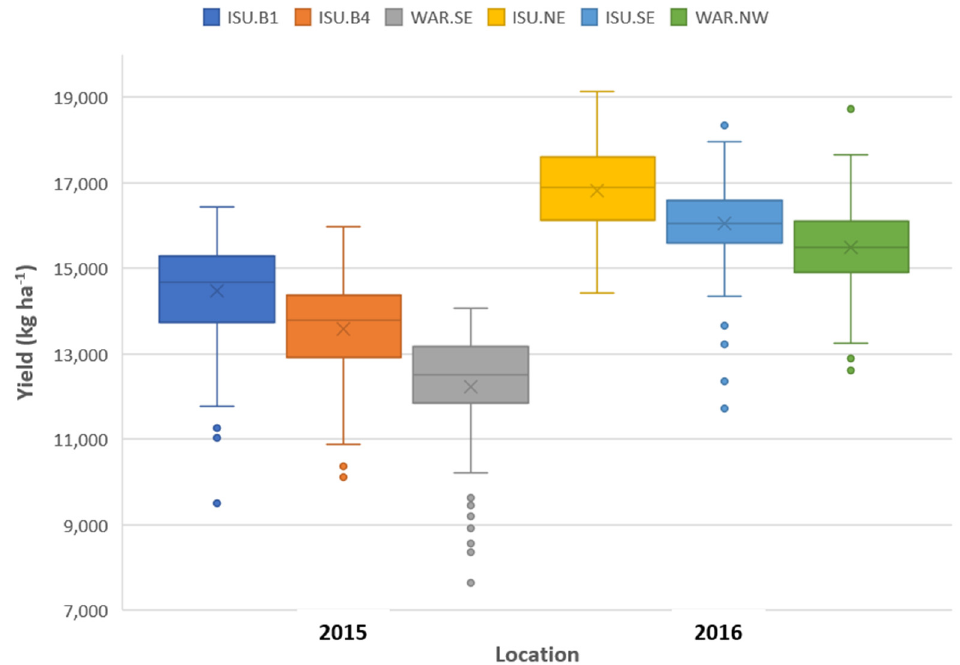
Figure 1. Summary statistics for six maize uniformity trials conducted to investigate the influence of plot size and shape on soil heterogeneity. X denotes the mean, horizontal line denotes the median, the box (rectangle) represents the interquartile region (IQR), and the whiskers (vertical lines) represent the upper and lower quartiles, respectively. Dots are outliers defined as being outside 1.5 × IQR. Variance per unit area decreased as plot size increased, and all six uniformity trials exhibited a negative asymptotic relationship between variance and plot size. Variance per unit area was reduced over 50% with plots 41.8 m 2 in size, and over 75% when using a plot size >111.5 m 2 compared to a 13.9 m 2 plot (Figure